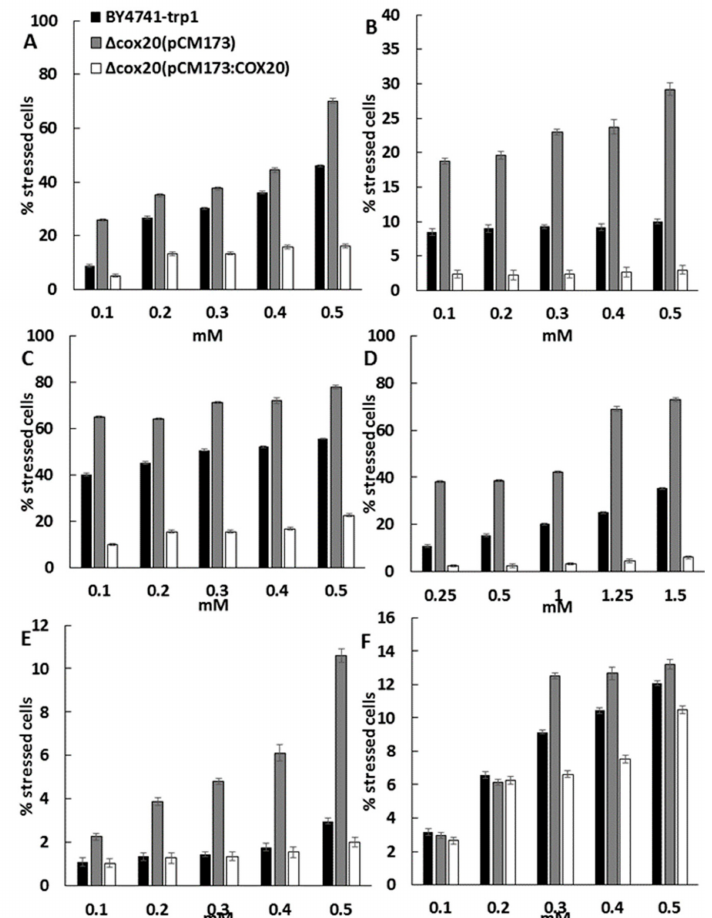
Figure 3. A summary of data from dot plot assays of yeast populations for BY4741-trp1, ∆ cox20 (pCM173), and ∆ cox20 (pCM173:COX20) in the presence of ( A ) 0.1–0.5 mM CuSO 4 , ( B ) 0.1–0.5 mM CoSO 4 , ( C ) 0.1–0.5 mM FeSO 4 , ( D ) 0.1–0.5 mM MnSO 4 , ( E ) 0.1–0.5 mM CdSO 4 , and ( F ) 0.1–0.5 mM ZnSO 4 . Data showing averages of triplicate assays with the standard deviation shown ( n =